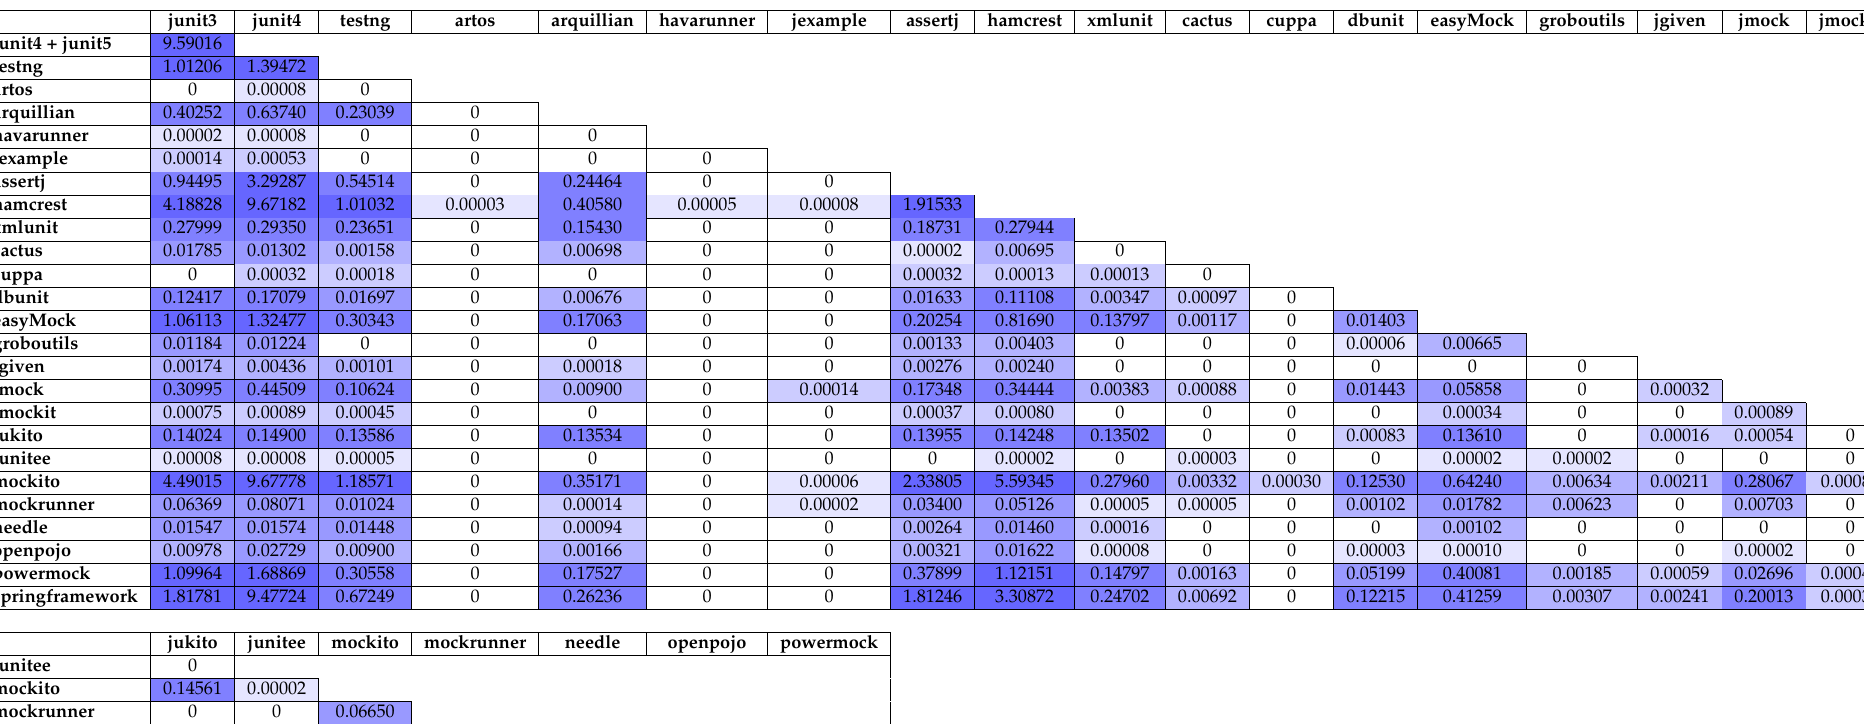
Table 1. Testing frameworks used